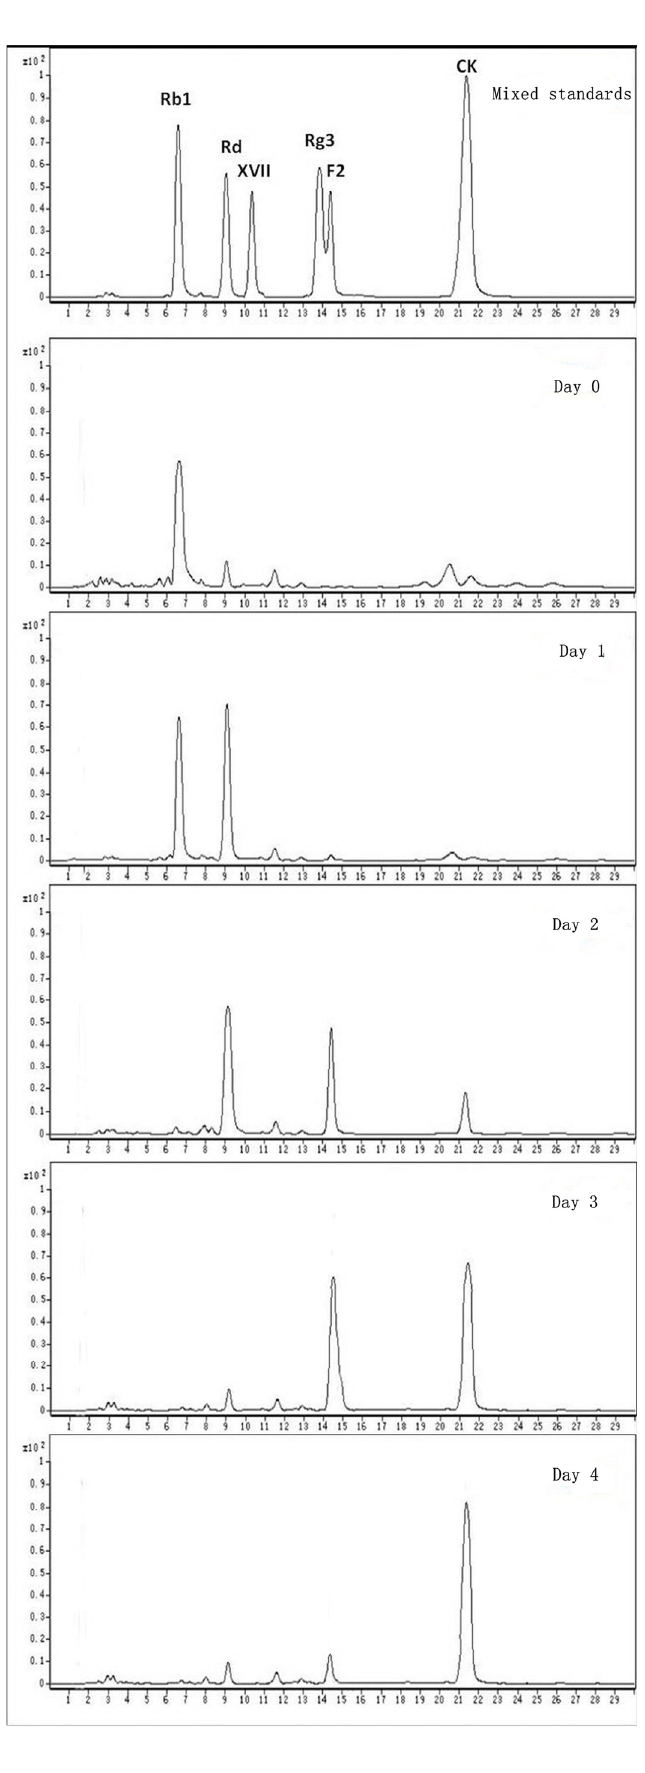
Figure 8. HPLC-MS analysis of the biotransformation pathway for ginsenoside